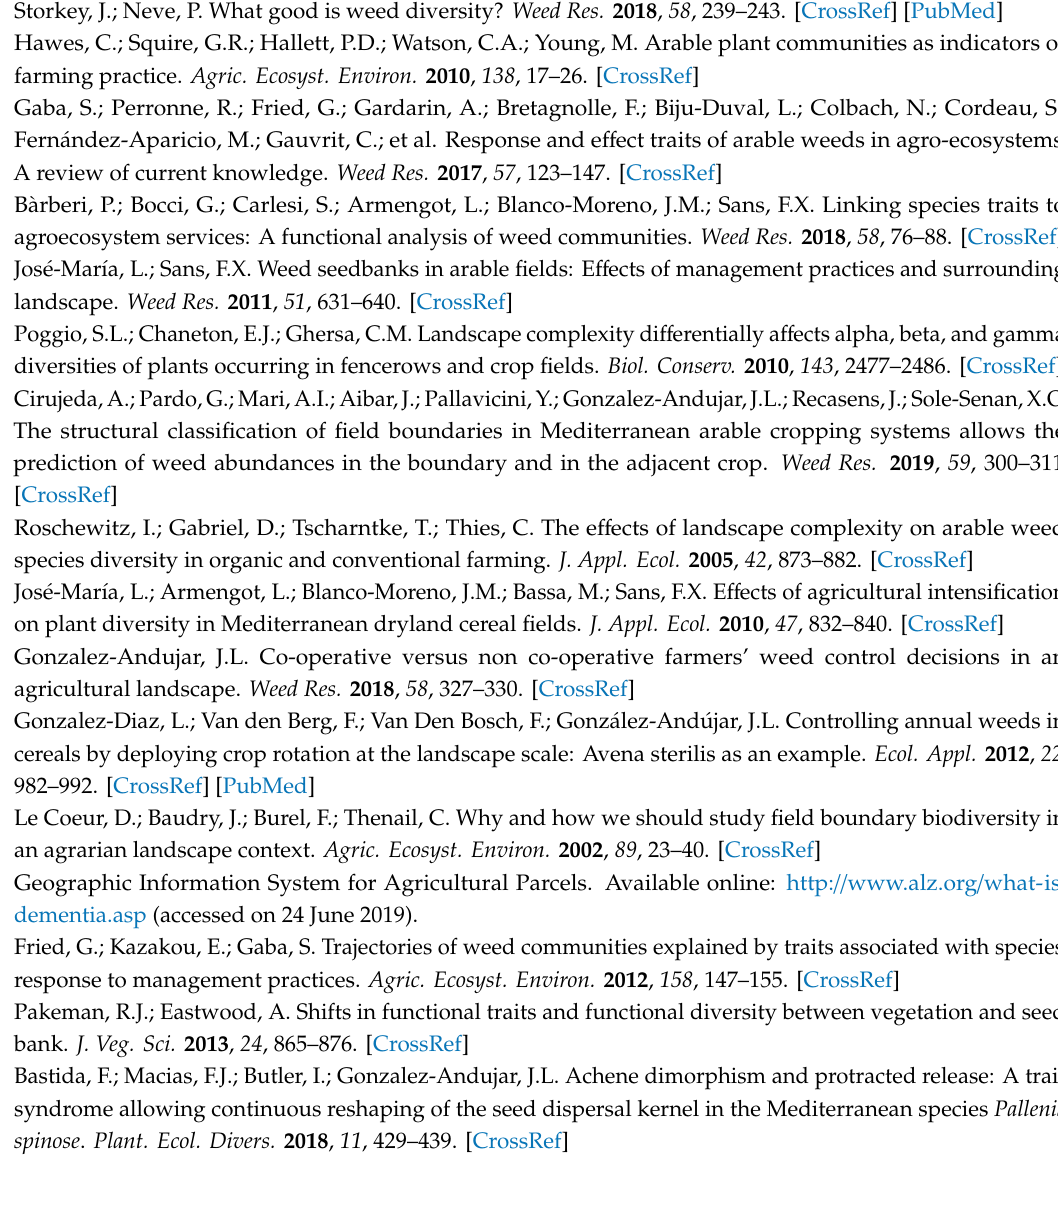
Table S1: Q table of the species recorded at a frequency ≥ 5% in the seed bank of sampled cereal fields in Andalusia (77 species) and Catalonia (62 species), Table S2: Frequency of the species recorded in Andalusia (175) and Catalonia (116). The species included in the functional analyses are shown in